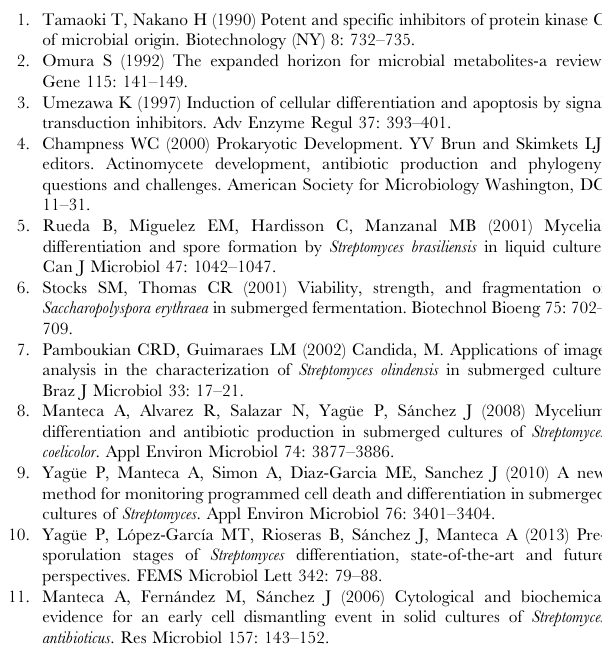
Table S1 Quantitative data for the expression of Streptomyces coelicolor transcripts. The relative abundanc- es of 7721 transcripts quantified in this work are shown as the log2 ratio of transcript abundance with respect to chromosomal DNA (Mg values) and to MI in both liquid (this work) and solid [16] cultures. Data are the average of three biological replicates and P- values are indicated. The 1901 transcripts quantified with very high confidence by Yagu¨e et al [16] in solid cultures (1901 transcripts) were compared with the transcripts obtained in this work for liquid cultures. Data were separated in four folders: three of them include data of Tables 1, 2 and 3; the other include data for transcripts without significant variations between solid and liquid